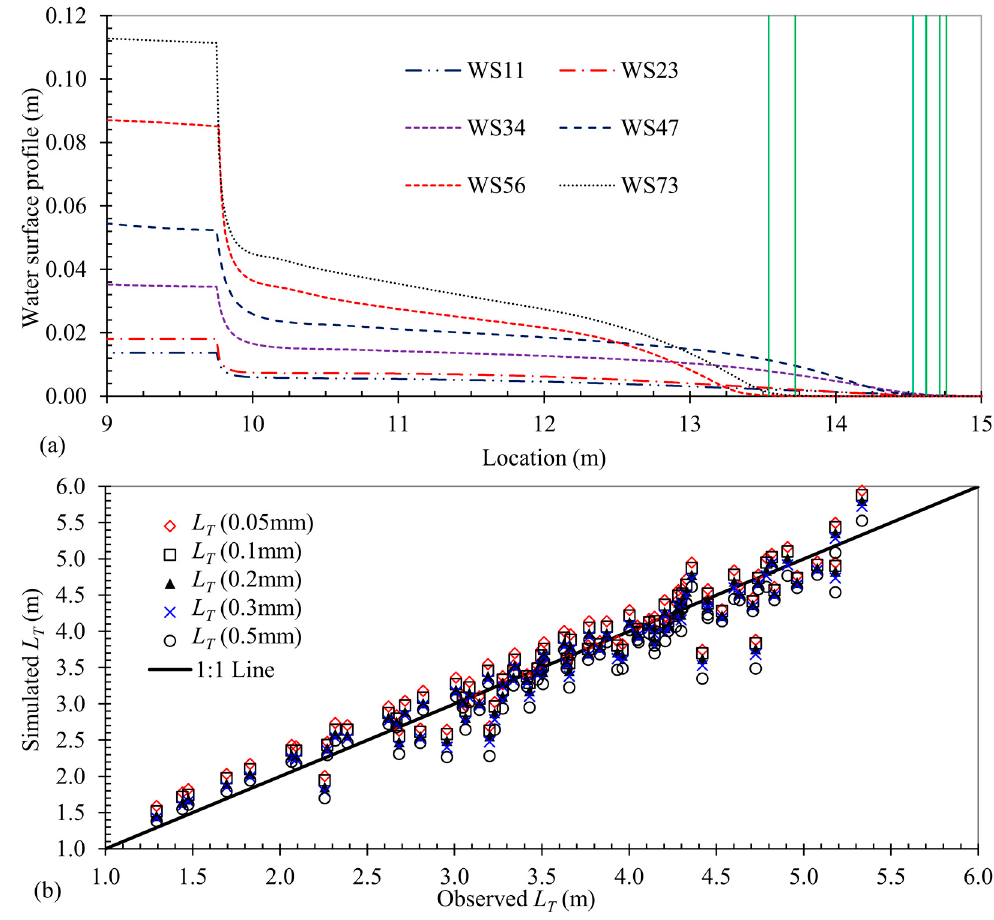
Figure 2. ( a ) Water surface profile along the curb inlet for six selected Wesley’s tests (WS11–WS73) and ( b ) comparison of simulated using five depth thresholds (0.05–0.5 mm) and observed 100% interception curb inlet lengths for 80 laboratory tests by Wesley (1961). The solid vertical lines in ( a ) show the location of the water depth equal to the depth limit of 0.2 mm for these six example cases.